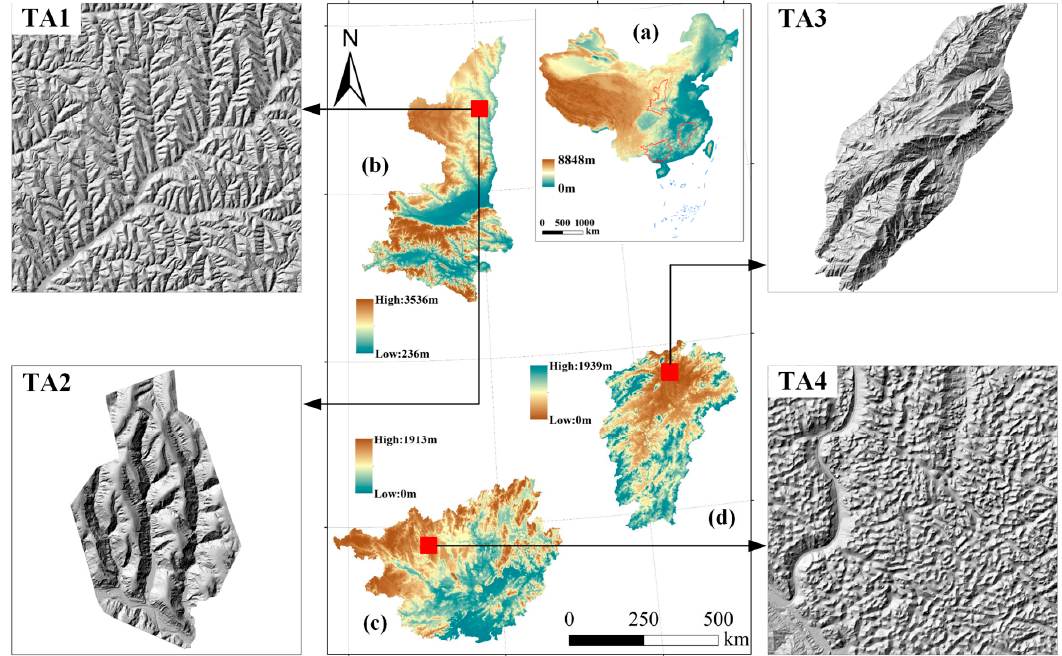
4 Figure 4. Ground study areas. ( a ) Study areas in China, ( b ) Suide area (TA1 and TA2) in Shaanxi